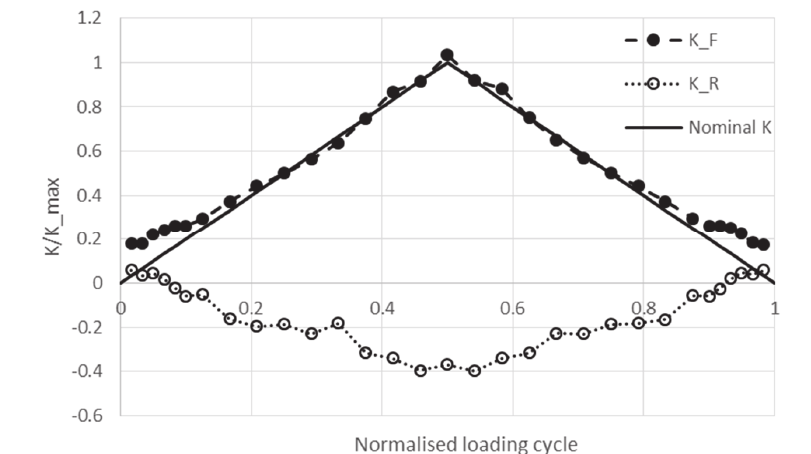
Figure 4: Results obtained by Vasco Olmo [8], showing the variation of K F and K R through a load/unload cycle for an Al4%Cu CT specimen. Results are normalized with respect to the nominal elastic